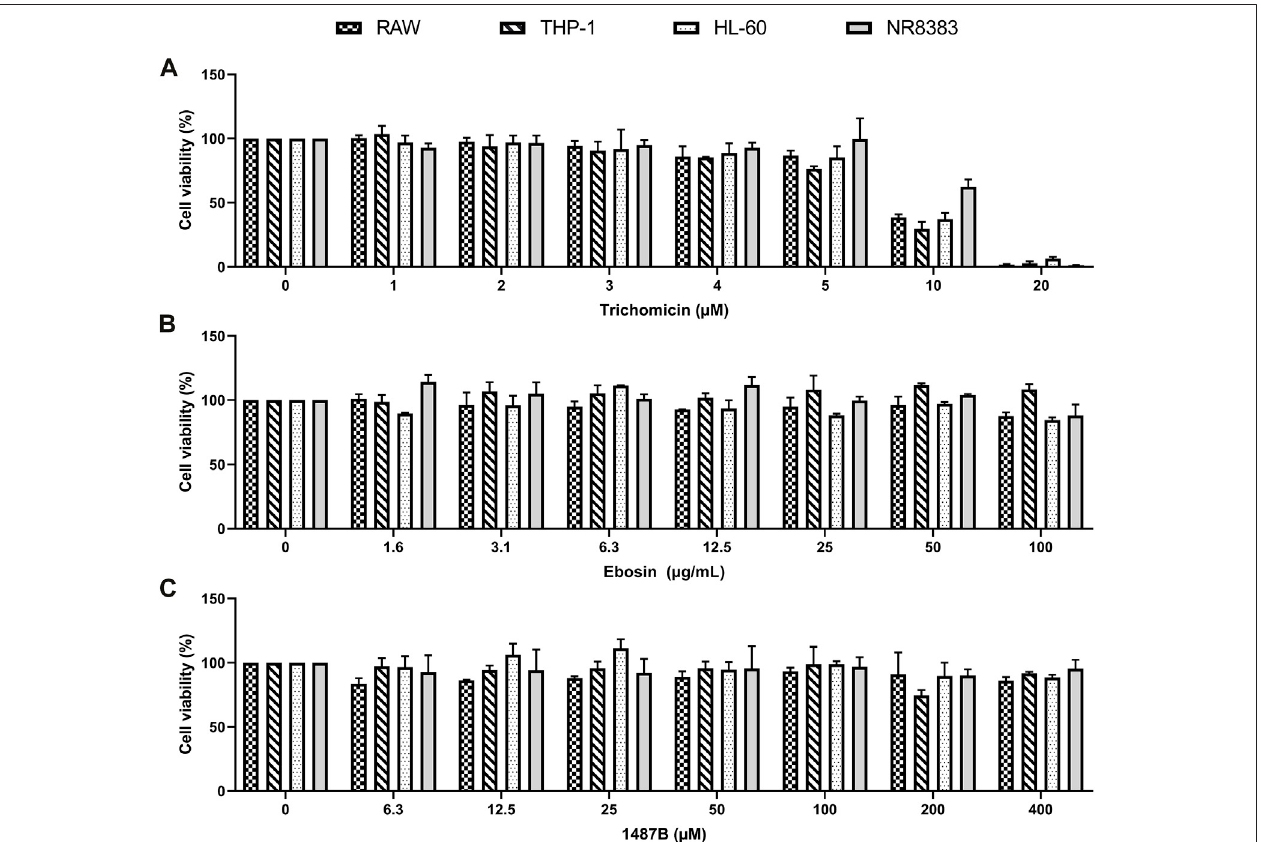
FIGURE2| EffectsofTrichomicin,Ebosinand1487BontheviabilityofRAW,THP-1,NR8383,andHL-60cells. (A) MTTassayofviabilityinthecellstreatmentwith 1,2,3,4,5,10,and20 µMTrichomicin. (B) MTTassayofviabilityinthecellstreatmentwith1.6,3.1,6.3,12.5,25,50,and100 µg/mlEbosin. (C) MTTassayofviabilityin the cells treatment with 6.3, 12.5, 25, 50, 100, 200, and 400 µM 1487B. (mean ± SD, n (cid:1) 6).